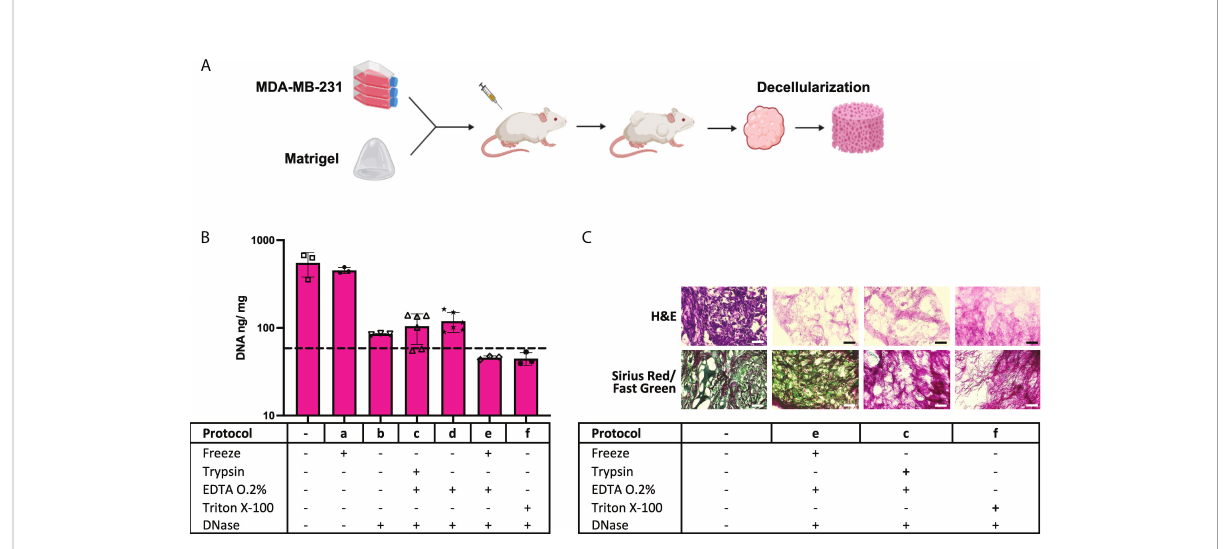
FIGURE 1 Enzyme and detergent-based protocols yield different decellularization outcomes. (A) Schematic of cell xenografting in mice: tumor formation, sample harvesting, and decellularization. (B) DNA quanti fi cation data on control samples and “ a ” to “ f ” protocol-treated samples ( n = 3 to 6). The dotted line indicates the 50-ng DNA/mg tissue threshold used to de fi ne successful decellularization. (C) Histology assessment of samples. (Black and white scales represent 100